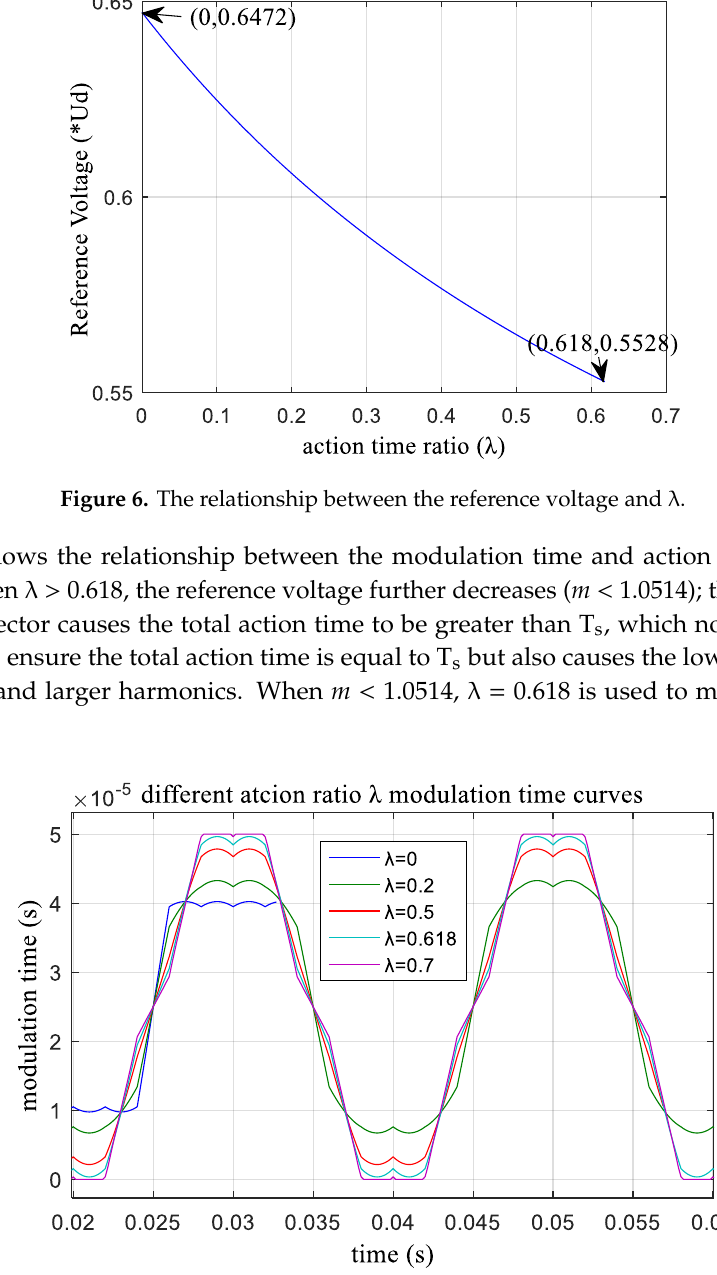
Figure 7. The modulation time-based action time ratio λ